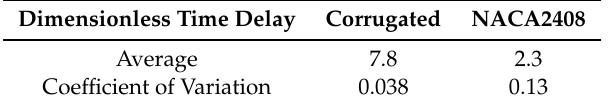
Figure 22. Time evolution of angle of attack and pitching relative moment coefficient of fluid force for the corrugated airfoil and NACA2408 airfoil at Re = 4000, with initial angle of attack of 0 ◦ ( r ρ C = 3.0 × 10 − 3 ). Table 4. Dimensionless time delay between angle of attack and moment